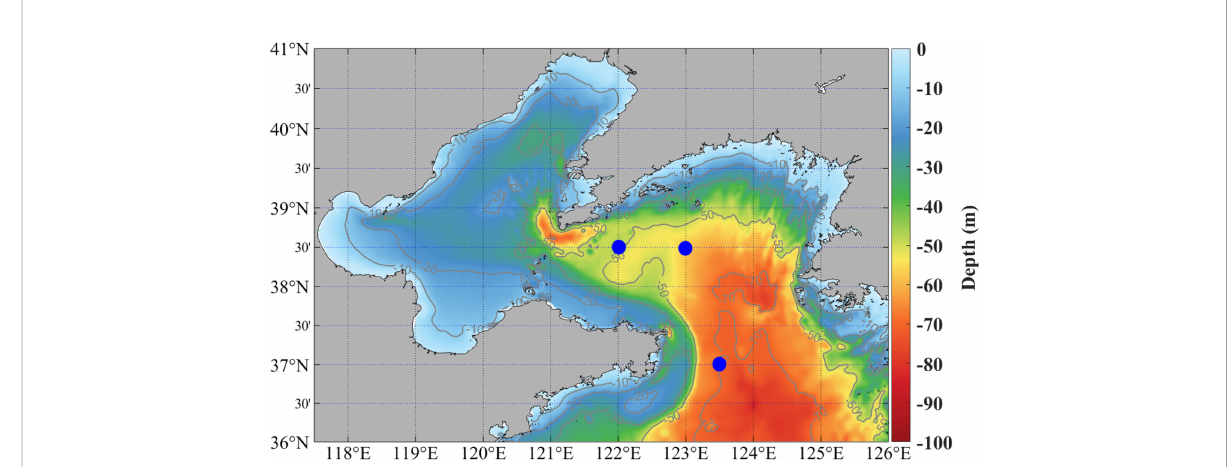
FIGURE 1 Sampling stations for M. senile and its food resources.